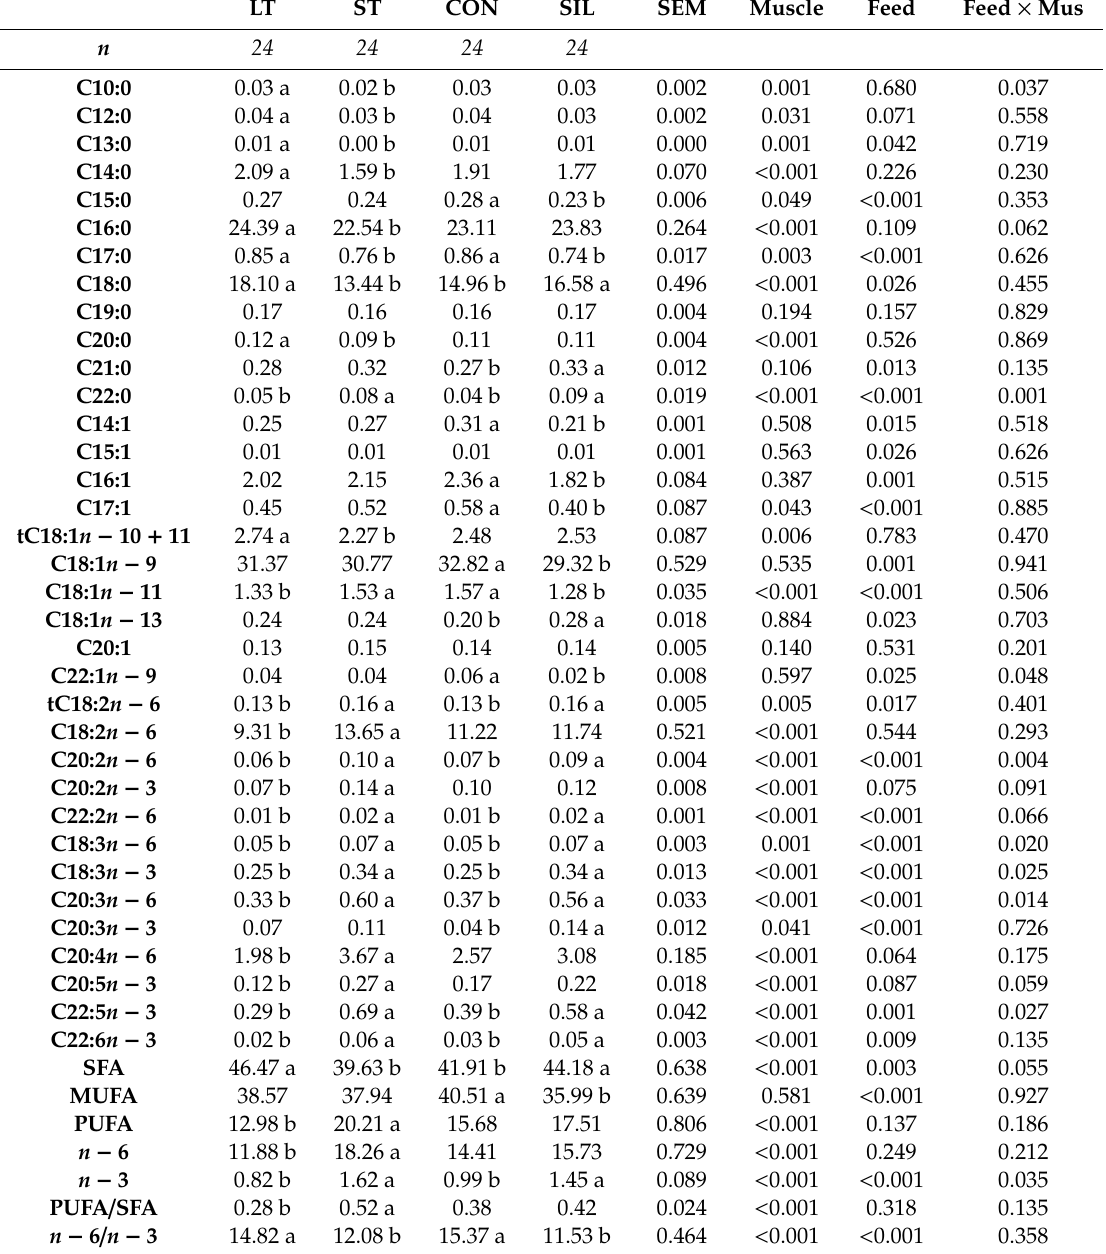
Table 4. E ff ect of muscle Longissimus thoracis (LT) and Semitendinosus (ST) and feeding (concentrate (CON) and 70% maize silage + 30% concentrate (SIL)) on fatty acids composition (g / 100 g of total fatty acids) of meat from Avileña-Negra Ib é rica